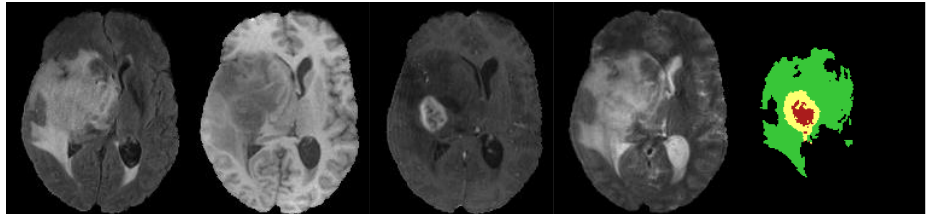
Figure 5. Visualization of a sample from the BraTS 2020 dataset. From left to right, there are Flair, T1, T1c and T2, respectively. The fifth image is the ground truth label. Label 1 is the necrotic and non-enhancing area in red. Label 2 is the edema area in green. Label 4 is the enhancing tumor area in